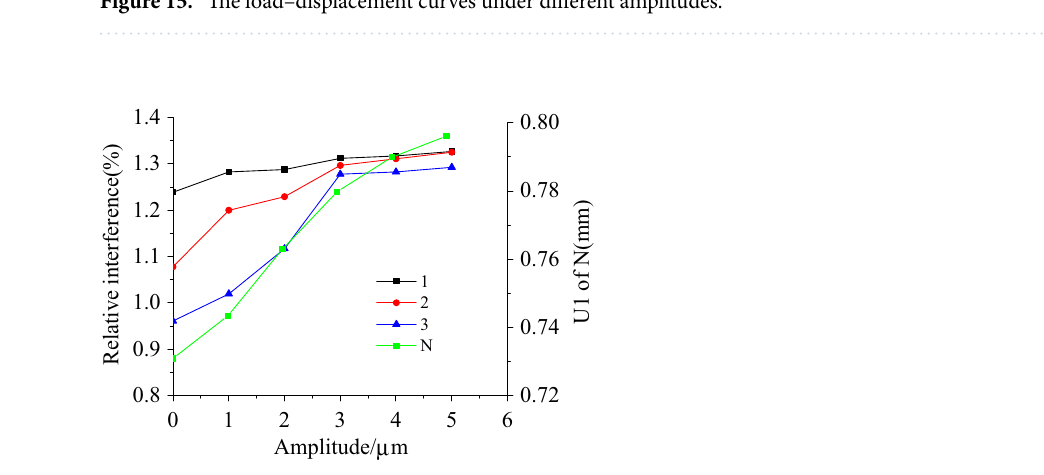
Figure 15. The load–displacement curves under different amplitudes.